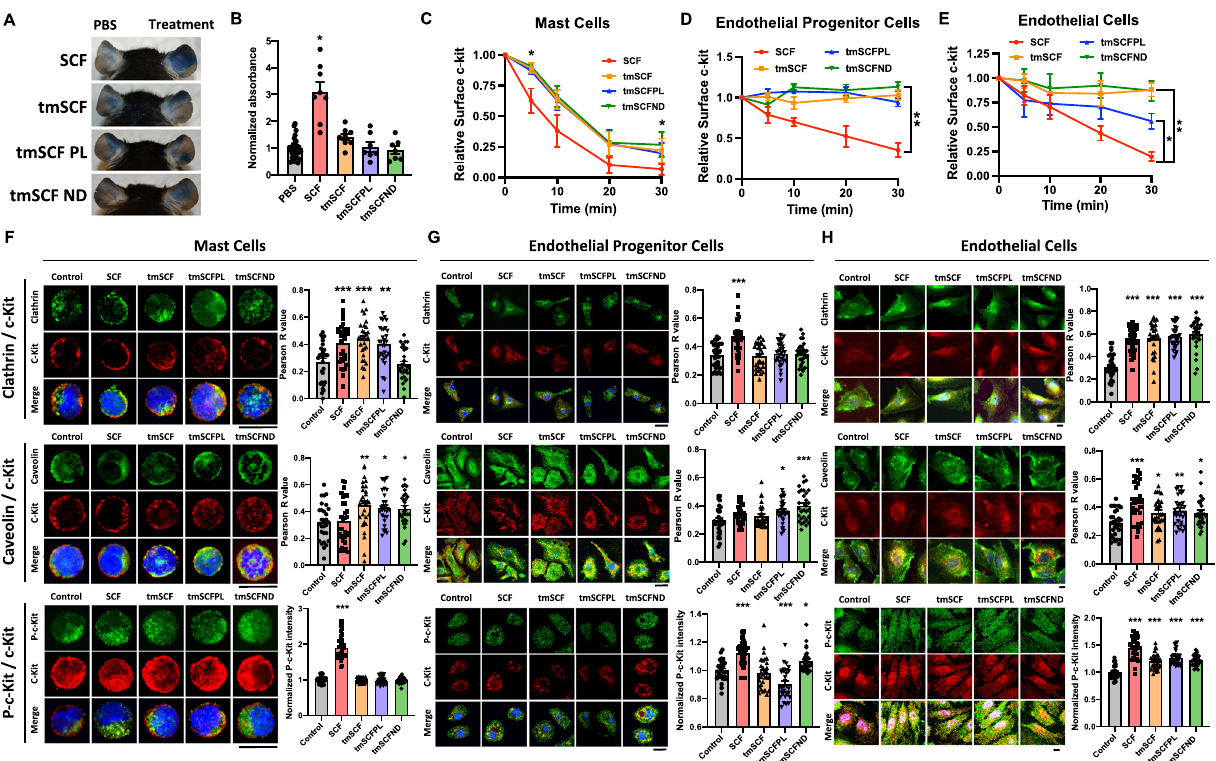
Fig. 2 Nanocarriers alter the uptake mechanism of tmSCF-based therapeutics. A Representative pictures of mice ears after Evan ’ s blue extravasation assay. PBS was injected to the left ear as a control and treatments were injected to the right ear ( n = 7 biologically independent mice examined over two independent experiments). B Quanti fi cation result of the absorbance at 620 nm. * p < 0.001 vs control. Two-sided one-way ANOVA with Turkey correction was used. ( n = 7 for tmSCFPL and tmSCFND, 8 for SCF and tmSCF, 26 for PBS). C Surface staining for c-Kit on MC9 mast cells was monitored by fl